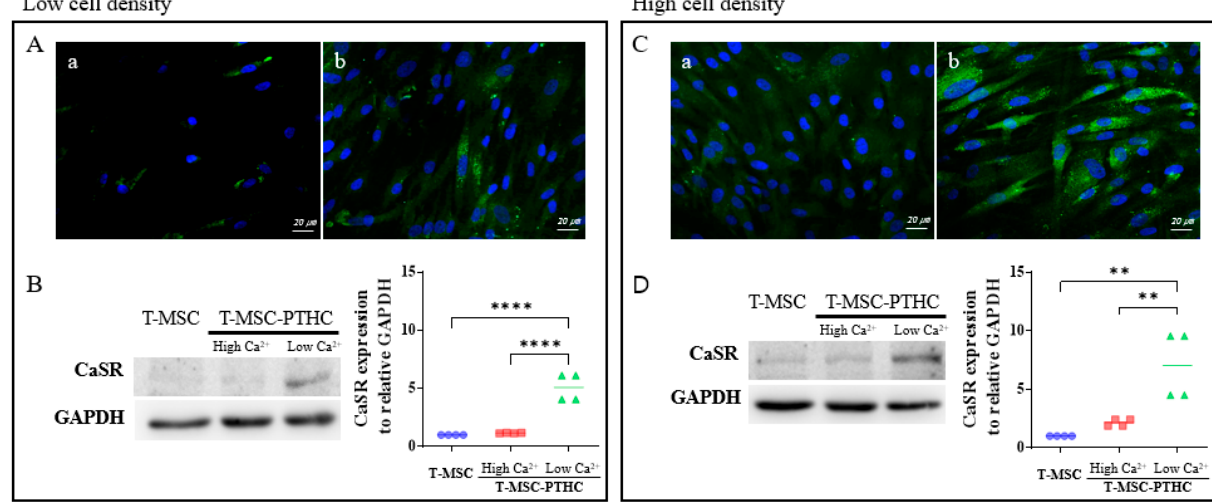
Figure 3. Comparison of differentiation potential of T-MSC-PTHCs according to cell density during differentiation (low cell density: A, B; high cell density: ( C , D )): ( A , C ) the expression of PTH (green) in T-MSC (panel a) and T-MSC-PTHCs (panel b) derived from donor #1 was evaluated by immunostaining. The cells were counterstained with DAPI (blue). The expression of PTH of T-MSC-PTHCs was higher in high-density cells ( C ) than low-density cells ( A ); ( B , D ) expression of CaSR protein according to extracellular calcium level in T-MSC-PTHCs from three donor #1. T-MSC-PTHCs were further exposed to culture media containing low (0.09 mM) or high (3.0 mM) calcium concentrations for up to 48 h. The expression of CaSR was measured by Western blotting and quantified using ImageJ software and are normalized to GAPDH. Data are presented as the mean ± SD of at least three experiments (** p < 0.01, **** p < 0.0001). In both densities of cells, the expression of CaSR protein was significantly increased under exposure to low calcium and was not significantly increased under exposure to high calcium. Abbreviations: PTH, parathyroid hormone; T-MSC, tonsil-derived mesenchymal stem cells; T-MSC-PTHCs, T-MSC-derived PTH-releasing cells; CaSR, calcium-sensing receptor; GAPDH, glyceraldehyde 3-phosphate dehydrogenase. Table 1. List of upregulated and downregulated cell cycle-related genes in T-MSC-PTHCs.